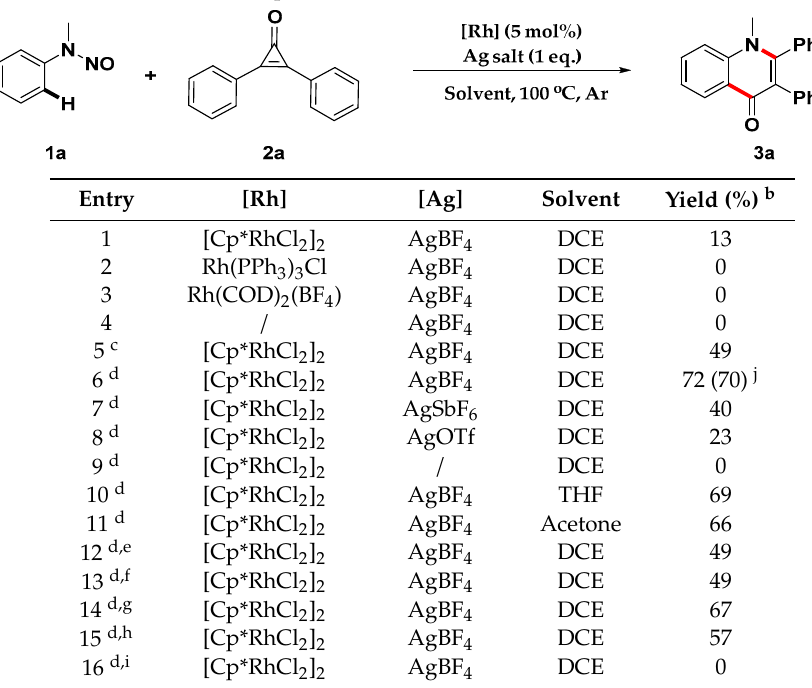
Table 1. Optimization of Reaction Conditions a .